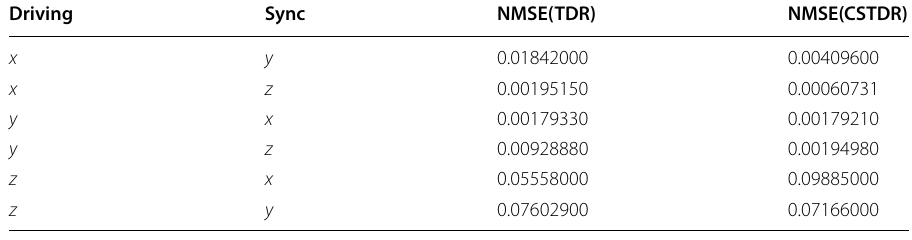
Table 2 Performance comparison of TDR and CSTDR computing for achieving chaos synchronization with Rossler system